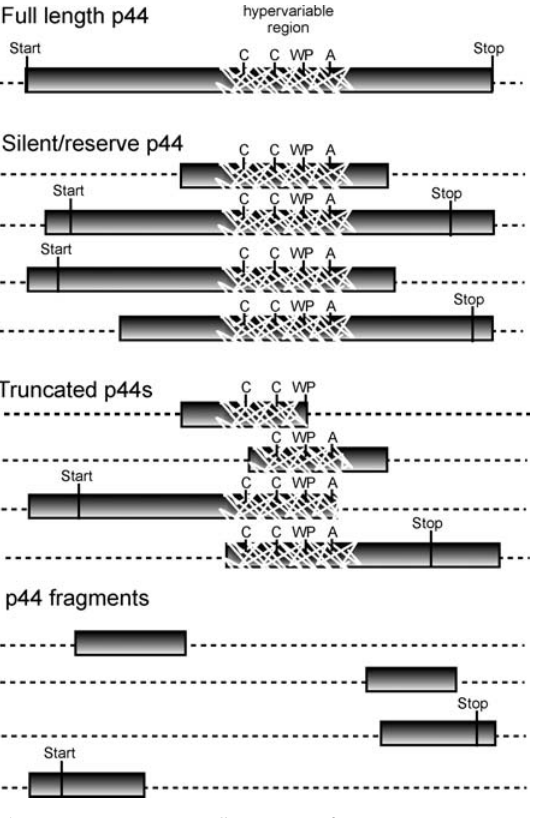
Figure 5. Representative Illustrations of p44 Genes Full-length p44 genes contain conserved start and stop codons, an ORF longer than 1,000 bp, and a central hypervariable region of approx- imately 280 bp containing a signature of four conserved amino acid regions (C, C, WP, A). These genes can be expressed at their respective current genome location or can recombine into the expression locus ( p44ES /APH_1221). A silent/reserve p44 is less than 1,000 bp. It may have either the conserved or alternative start and/or stop codons. A silent/ reserve p44 is not likely to be expressed at its current genome location, but can recombine into the expression locus ( p44ES /APH_1221). Truncated p44 s carry the complete hypervariable region, or a portion thereof, but only one of the two conserved regions. Fragments of p44 have only a conserved region and no hypervariable region. Each annotated p44 is longer than 60 bp. It should be noted that smaller fragments can be identified throughout the genome. These, as well as